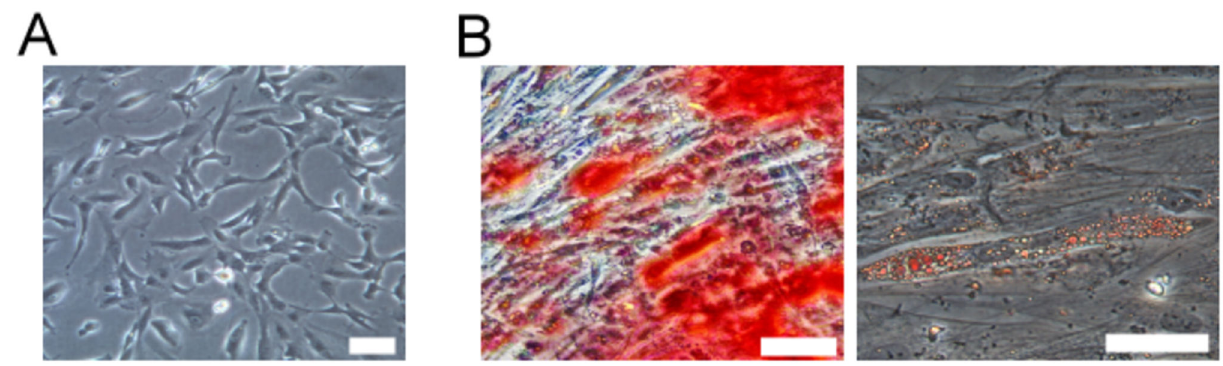
Figure 1. The morphology and mesenchymal differentiation potential of AFSCs. AFSCs are morphologically heterogeneous and are shown in small and polygonal shapes (A). After osteogenetic and adipogenetic induction for 21 days, the AFSCs were stained by Alizarin Red S (B, left) and Oil Red O (B, right), respectively. Bar: 10 µm. doi: